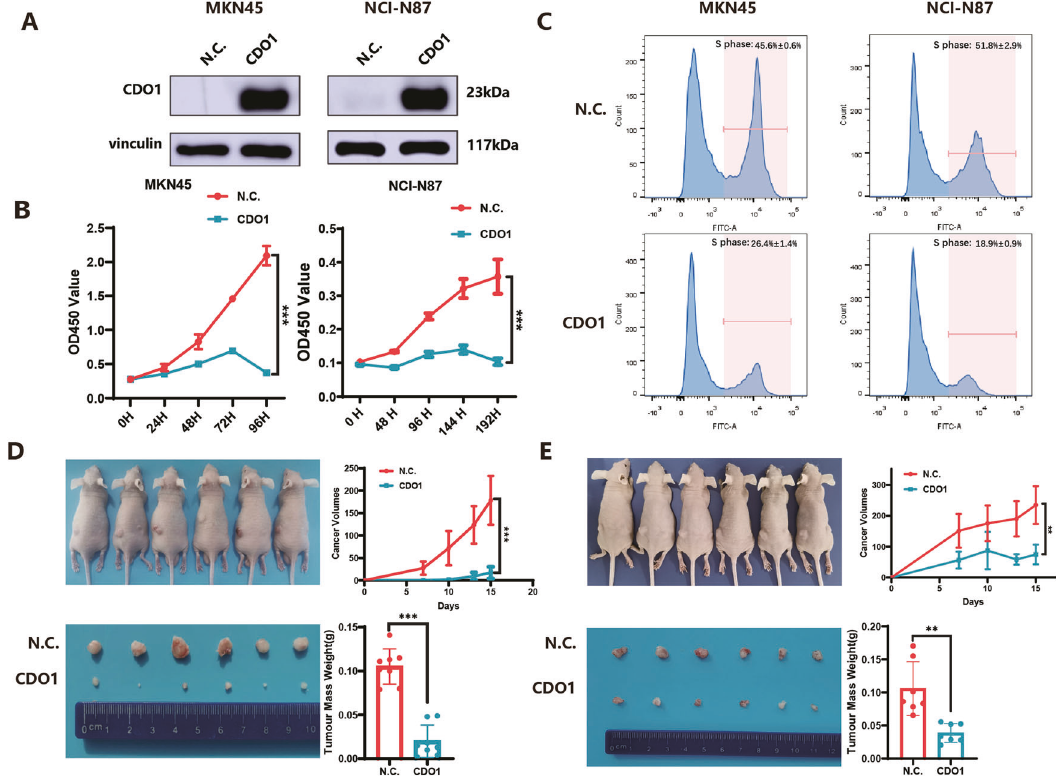
Fig. 2 The inhibitory effect of CDO1 on the proliferation in GC cells. A The re-expression ef fi ciency of CDO1 in MKN45 (left panel) and NCI- N87 (right panel) cells was veri fi ed by immunoblots. B Cellular growth of MKN45 (left panel) or NCI-N87 (right panel) cells from N.C. or CDO1- restored group was assayed using CCK-8 at the indicated time points respectively ( N = 6, mean ± SD), showing that CDO1 remarkably suppressed the proliferation in these two GC cell lines. C MKN45 (left panel) or NCI-N87 (right panel) cells from N.C. or CDO1-restored group were stained with EdU and analyzed fl ow cytometry, showing that CDO1 markedly blocked the proliferation in GC cells. One representative result ( N = 3, mean ± SD) are graphically presented here. D , E Tumor xenografts model based on female Balb/c nude mice demonstrated that the proliferation of MKN45 ( D ) and NCI-N87 ( E ) cells was substantially inhibited by CDO1 in vivo, as evidenced by the delayed growth at the indicated time intervals and the decreased weights of the tumor masses from MKN45 or NCI-N87 cells. ** p < 0.01, *** p <